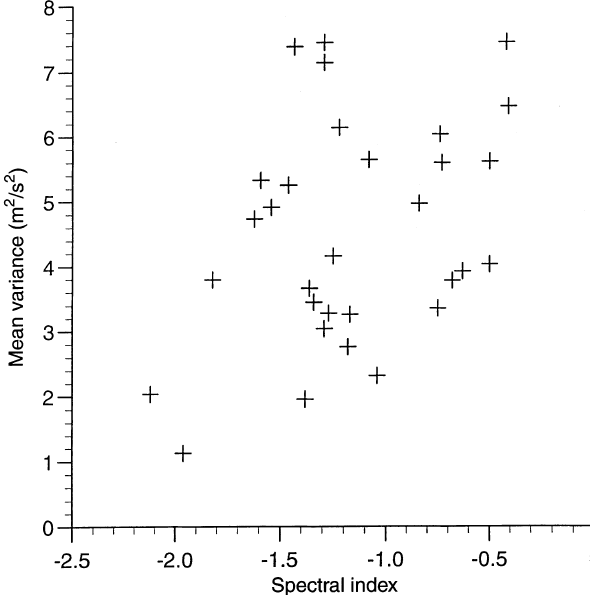
Fig. 10. The spectral index (slope) as a function of daily-mean variance over the height range 76–86